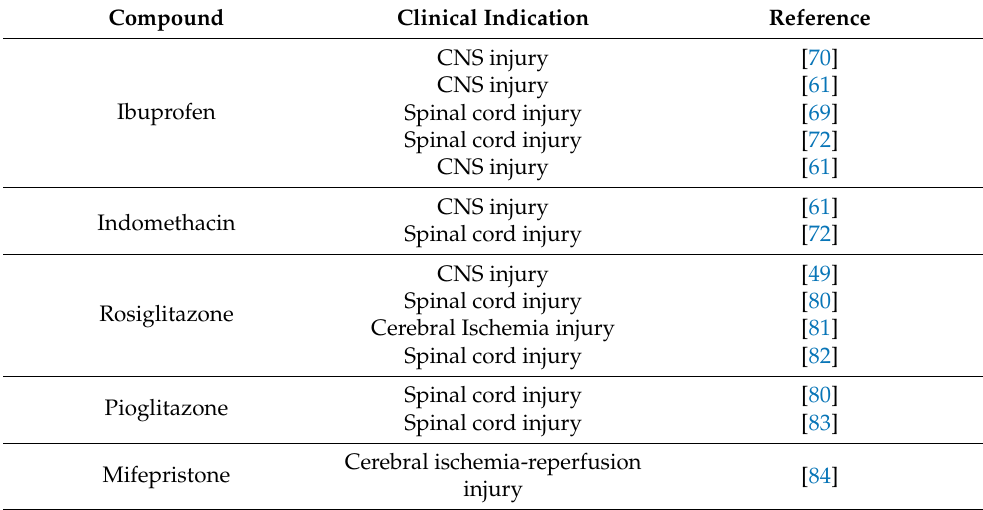
Table 2. Studies that have explored the effect of drugs and other experimental small molecules targeting the PPAR- γ in the